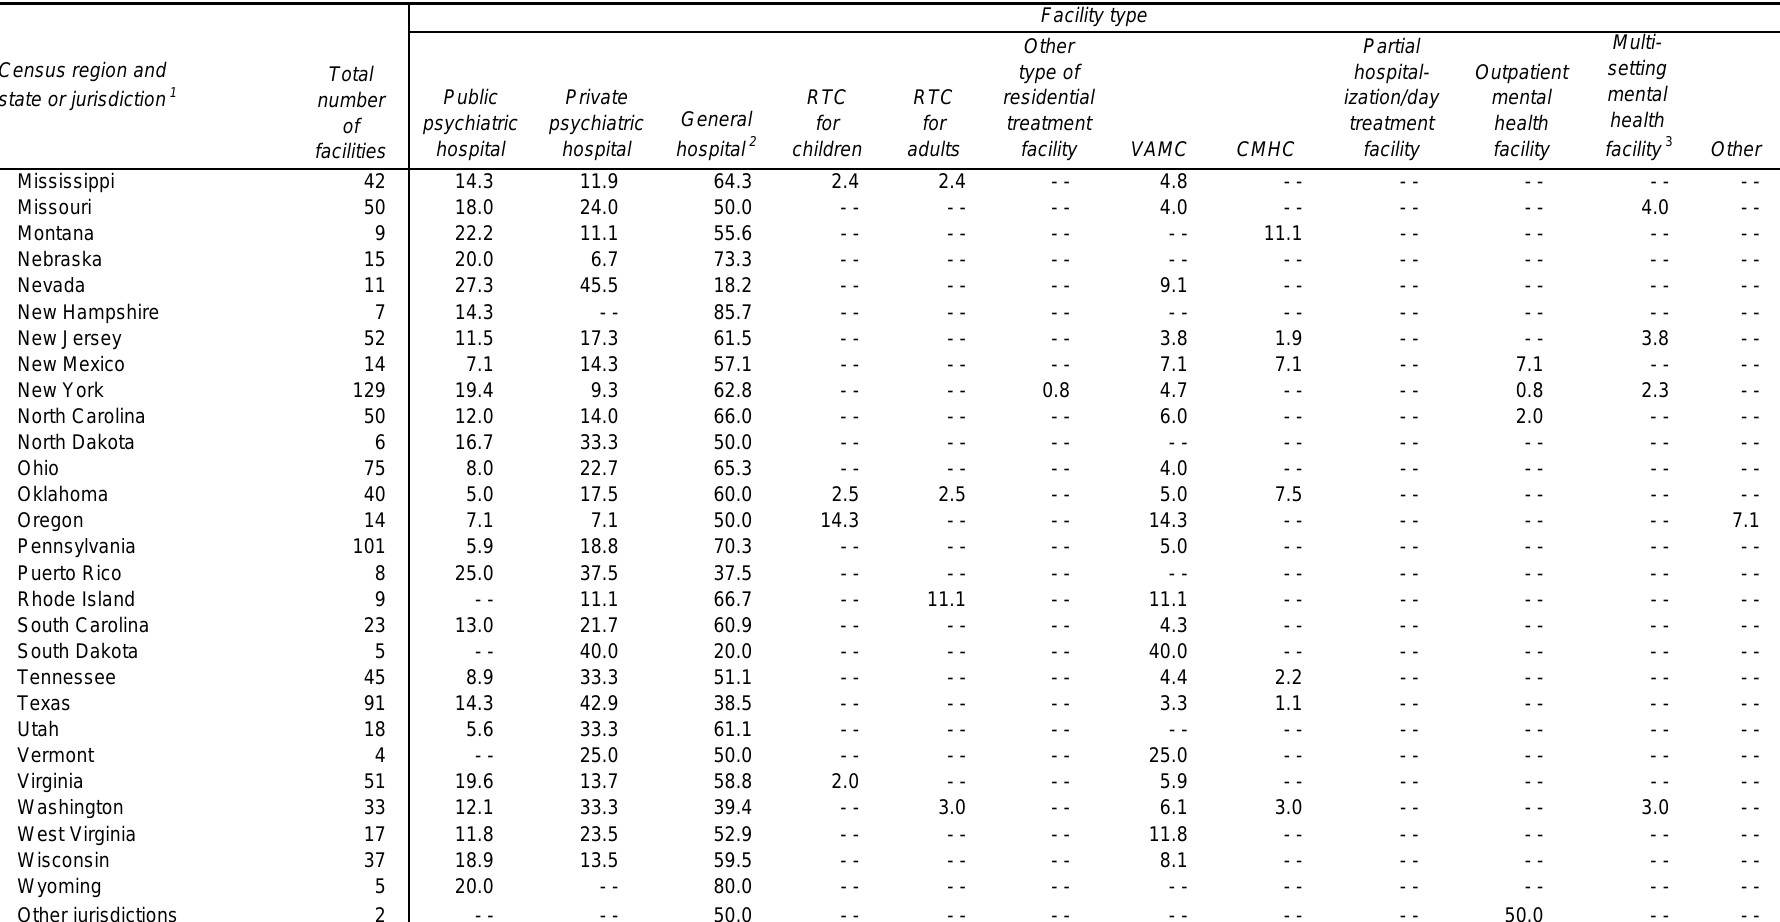
Table 3.3b. Mental health treatment facilities providing 24-hour hospital inpatient treatment, by facility type, Census region, and state or